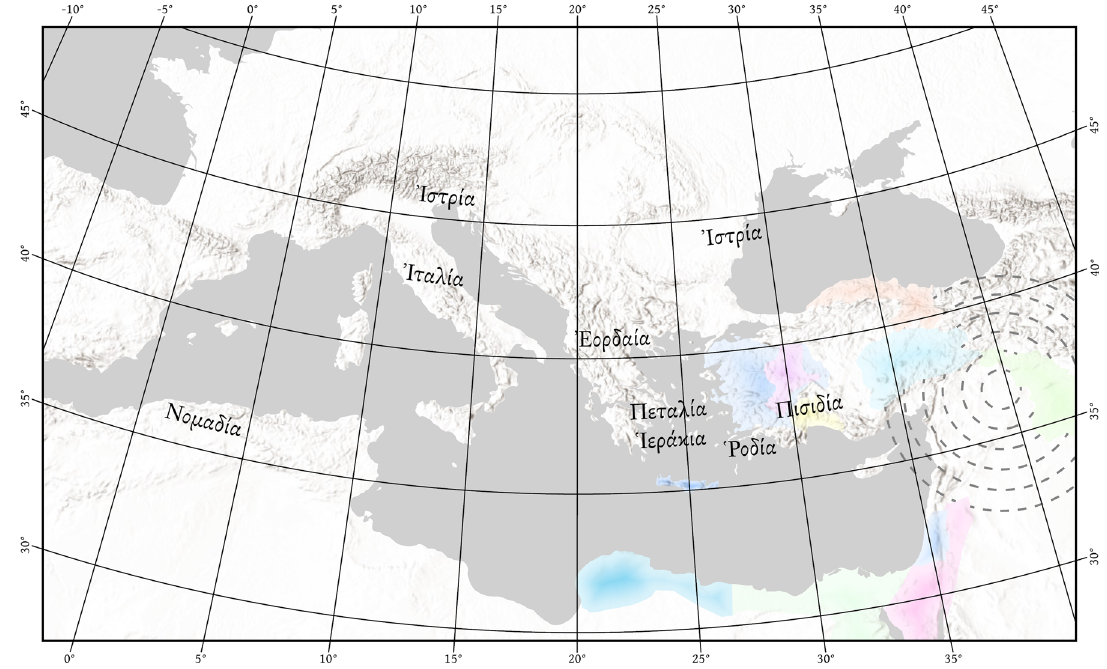
Figure 5: Map of regional toponyms that are paleographically close to